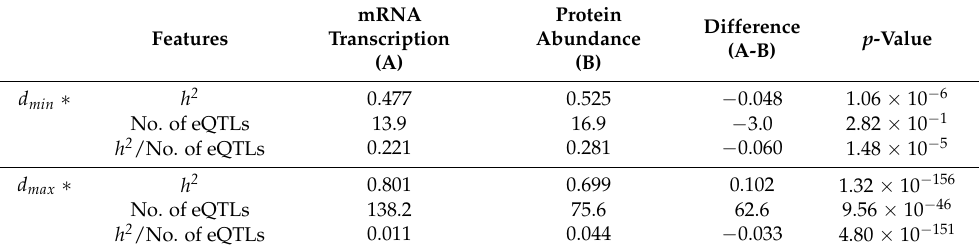
Table 1. The characteristics at the minimum and maximum differences in heritability between mRNA transcription and protein abundance, explained by expression quantitative trait loci (eQTLs).